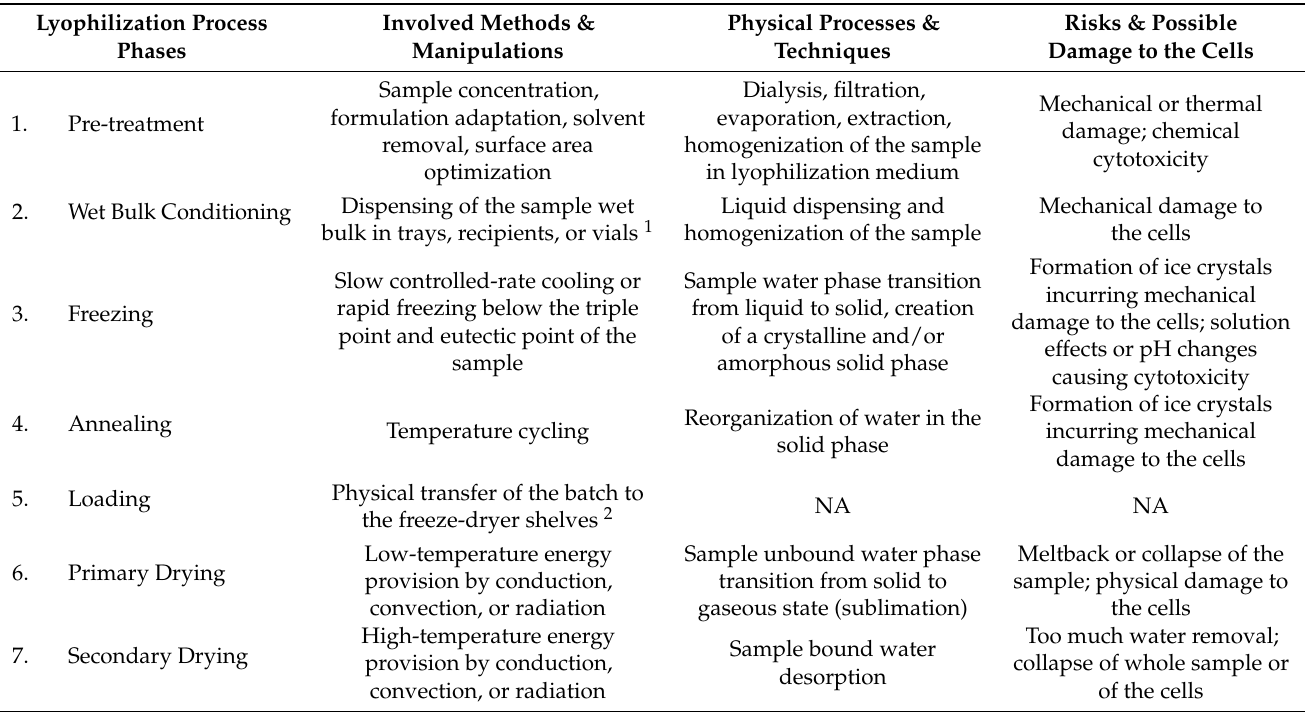
Table 2. Process phases, involved methods, and physical processes/techniques of lyophilization for cell suspensions and cytotherapeutic derivatives from pre-treatment to storage. This standard approach is used in the cytotherapy-inspired workflows investigated under the Swiss progenitor cell transplantation program. Involved risks and possible damage to the cells or to the cytotherapeutic derivatives are presented for each step. An illustrated workflow describing the various lyophilization steps is presented in Figure S3. NA,